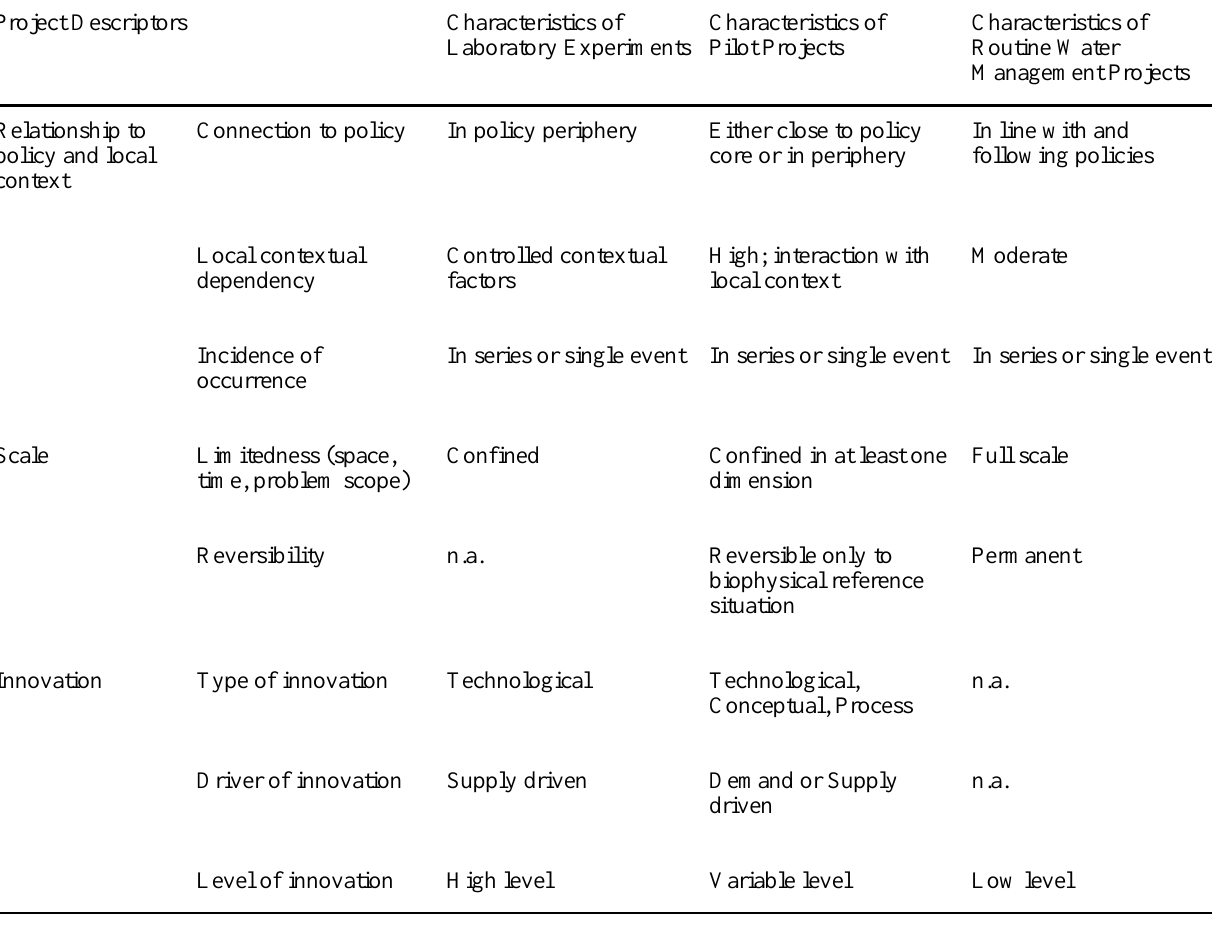
Table 1 . Pilot projects compared and contrasted with laboratory experiments and routine water management